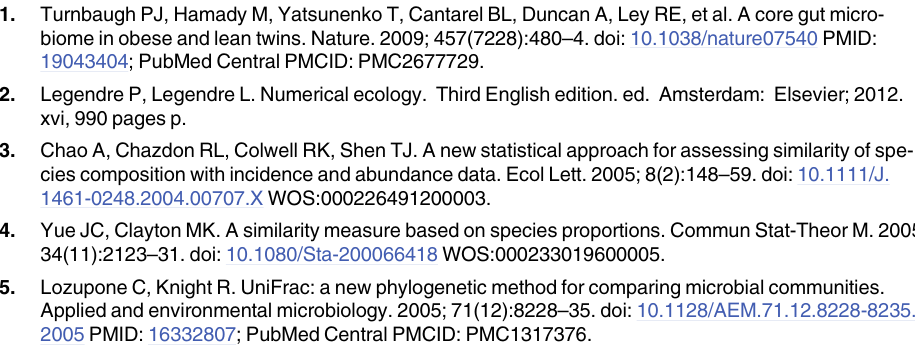
S1 Fig. Percentage of unique k -mer sequences for four bacterial species. For further descrip- tion see Methods. S2 Fig. Variation of percent similarity with coverage for random pairs of samples. GUTSS similarity scores (dots with dashed lines to guide the eye) for 3 HMP adult gut microbiome samples with low, average and high Shannon diversity (SD). Solid lines are models for the A . baumannii (with dots for GUTSS scores) and Homo sapiens genomes. For further description see Methods. S1 Table. Species used to construction the gut microbiome simulated communities and the NIH Sequence Read Archive (SRA) accession numbers. S2 Table. HMP gut microbiome metagenomics sample accession numbers and their (paired) similarity